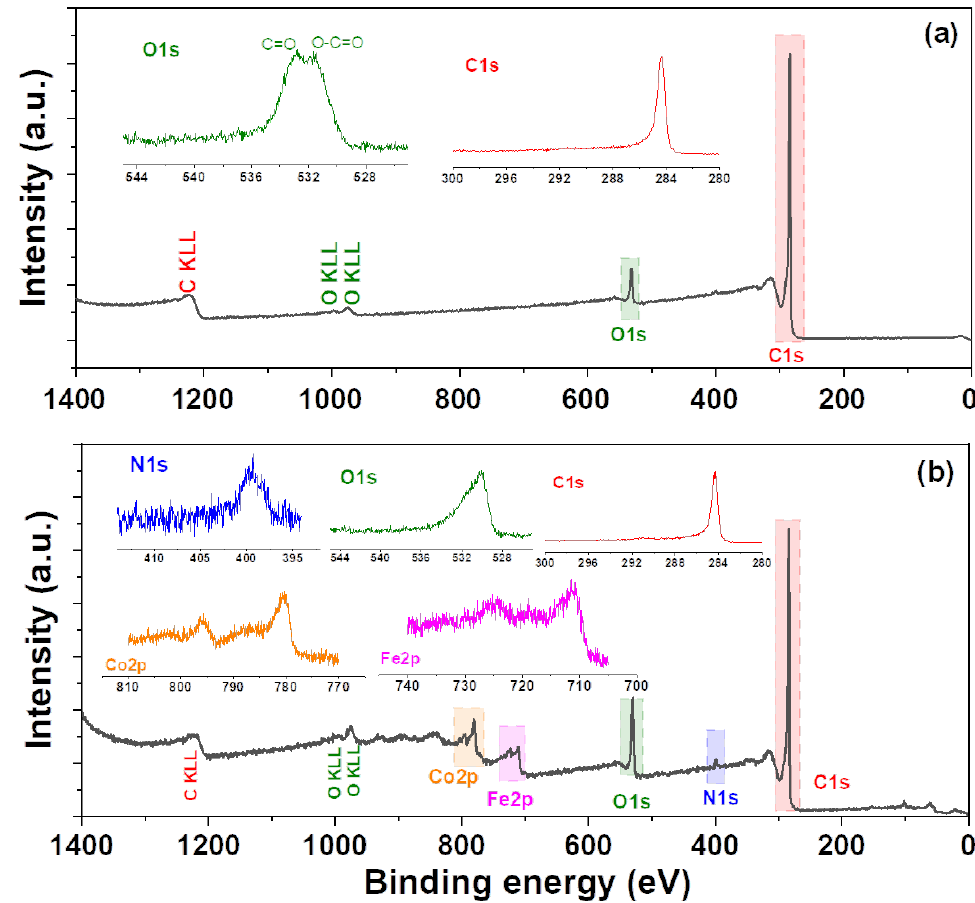
Figure 4. Summarized XPS analysis of GO ( a ) and CoO x -Fe 3 O 4 /N-rGO ( b ). Insets show the high- resolution elemental scans. Table 1. Elemental composition data obtained from XPS analysis.